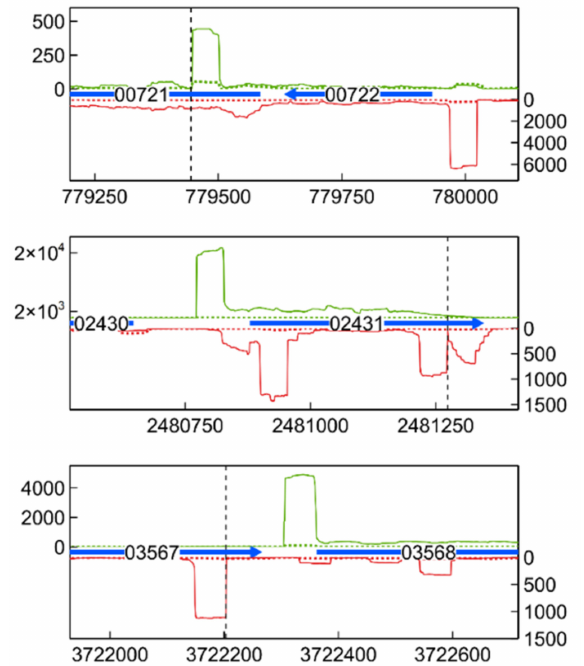
Figure 9. Transcription profile of identified aTSSs for selected genes. Combined TSS read counts of the three biological replicates of Cu-exposed (solid line) and unexposed (dotted line) stalked cells in M2G medium are shown for the positive (green) and negative (red) strand. Coding sequences are represented by a horizontal blue arrow (number is CCNA_ locus tag, x axis positions being the genomic location). Detected aTSSs are indicated with a vertical dashed line.